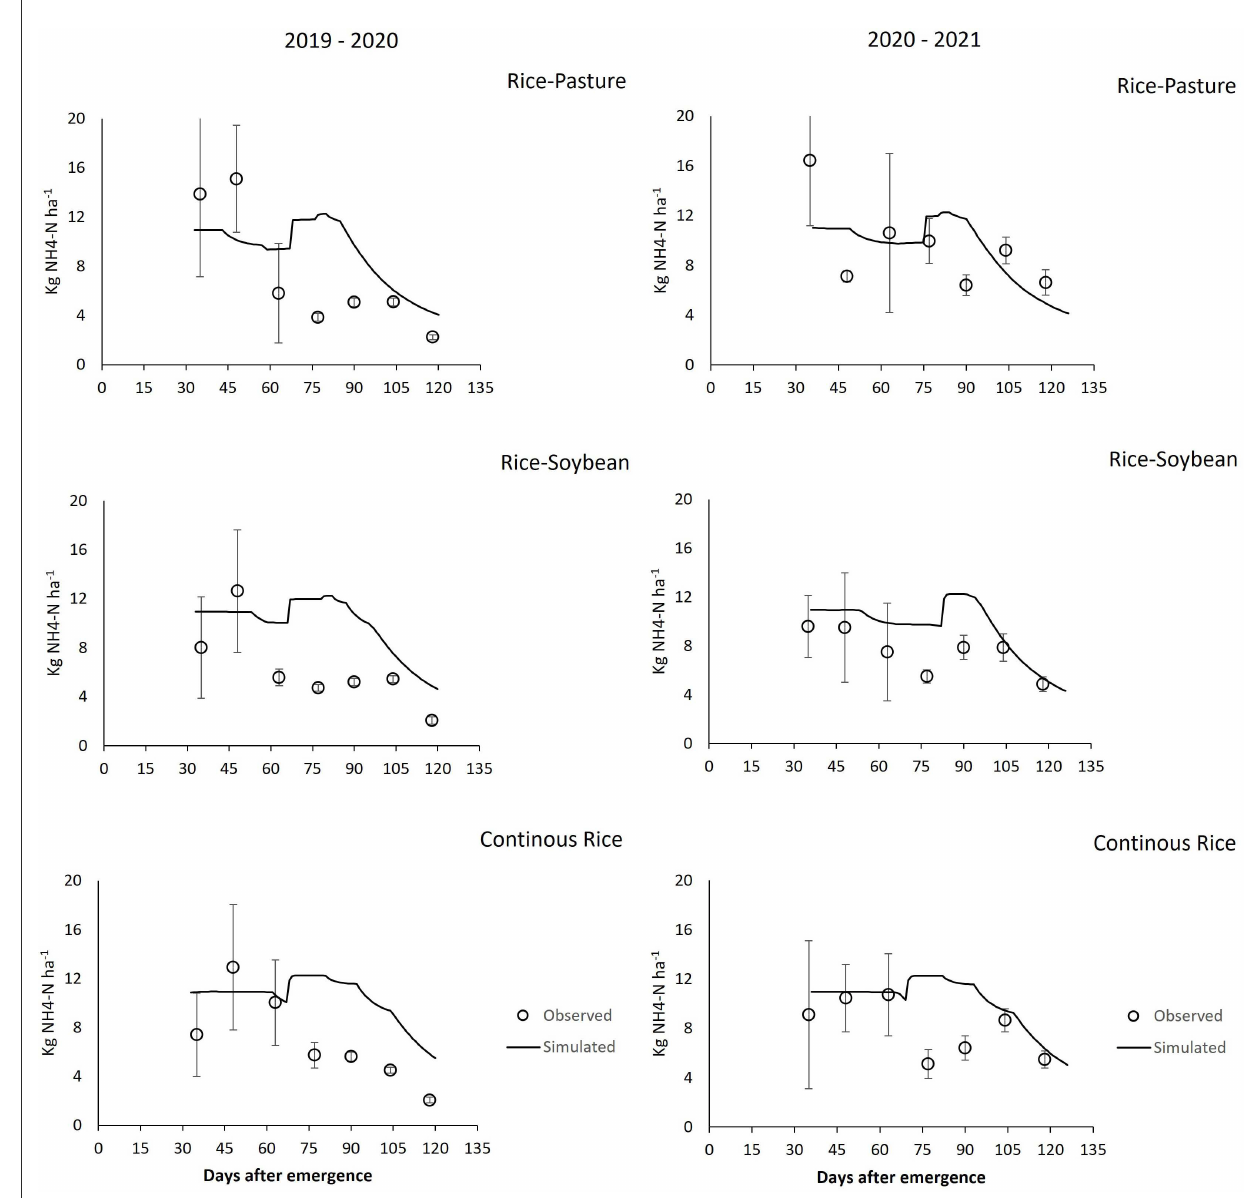
FIGURE4 Comparison of simulated and observed NH 4 -N concentration in the soil during the flooded rice stage in rice-pasture, rice-soybean and continuous rice in 2019–2020 and 2020–2021 growing seasons. Observed data are means ± standard errors ( n = 3).